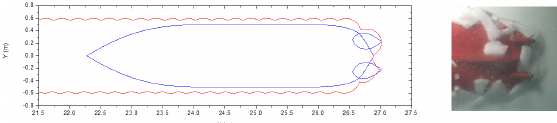
Figure 7: Icebreaking pattern around the headbox in 52 mm (1 . 26 m full-scale) level ice.